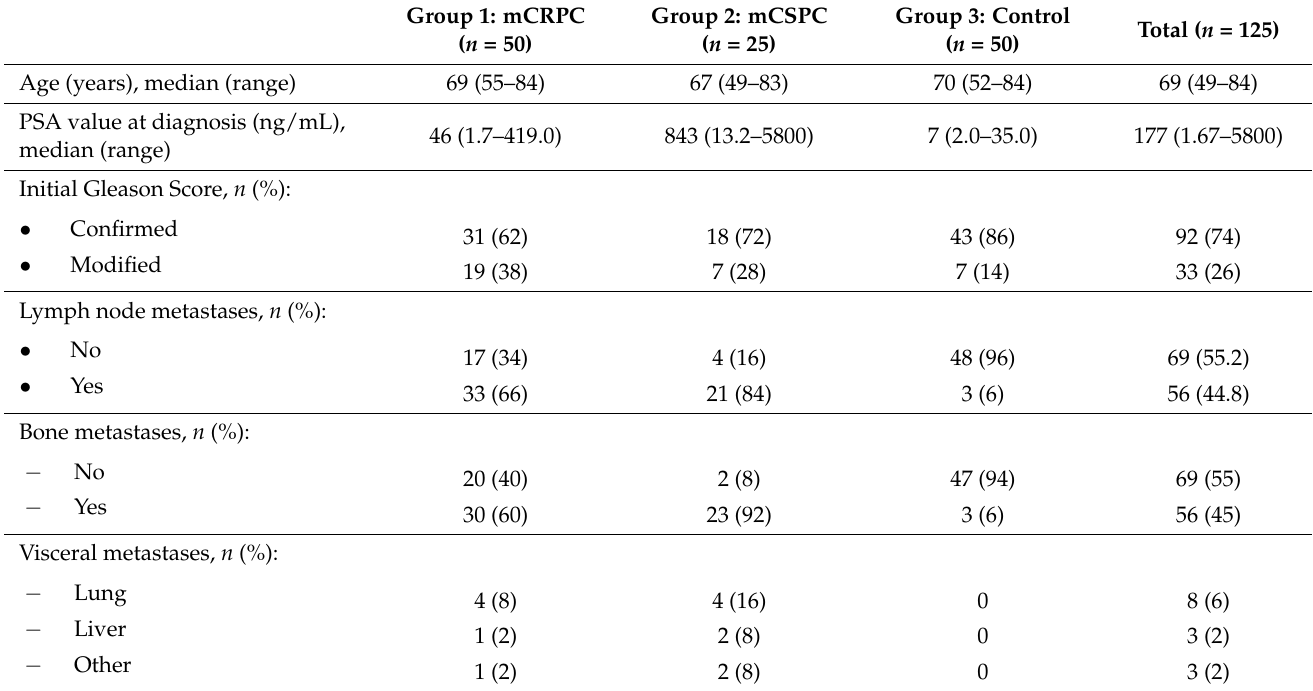
Table 1. Baseline patients’